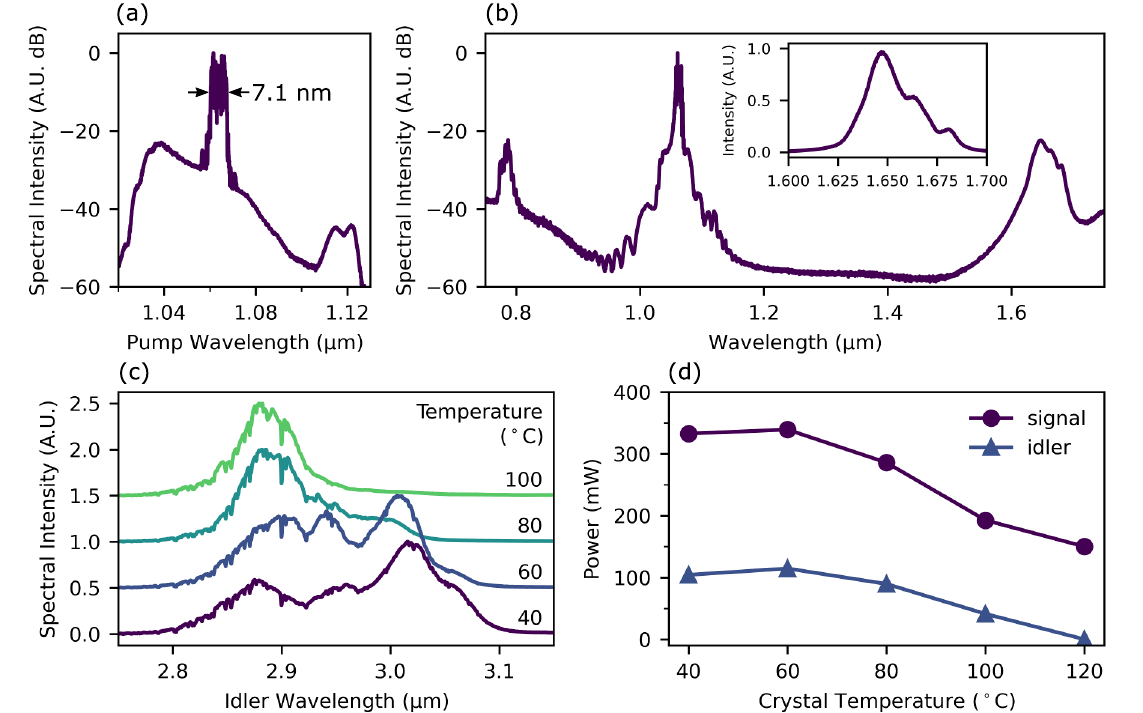
Figure 3. (a) MOPA pump laser spectrum centered at 1.064 µ m, with bandwidth of 7.1 nm. (b) Spectrum at output of PCF showing 1.064 µ m pump and 4WM sidebands. Inset: Stokes sideband on linear scale. (c) Idler spectral tuning with crystal temperature on linear scale (d) Generated signal and idler powers as a function of